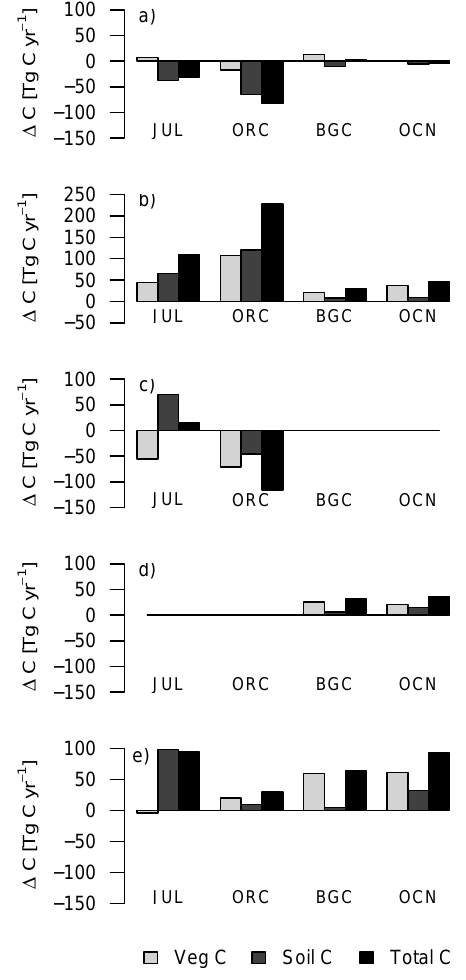
Fig. 4. Changes in soil and vegetation carbon pools in response to climate (a) , atmospheric carbon dioxide concentration (b) , land cover change (c) , atmospheric nitrogen deposition (d) , and three factors together (e) . Each bar represents annual change in carbon stock averaged over 1951–2000. Carbon stocks are estimated with JULES, ORCHIDEE, BIOME-BGC, and